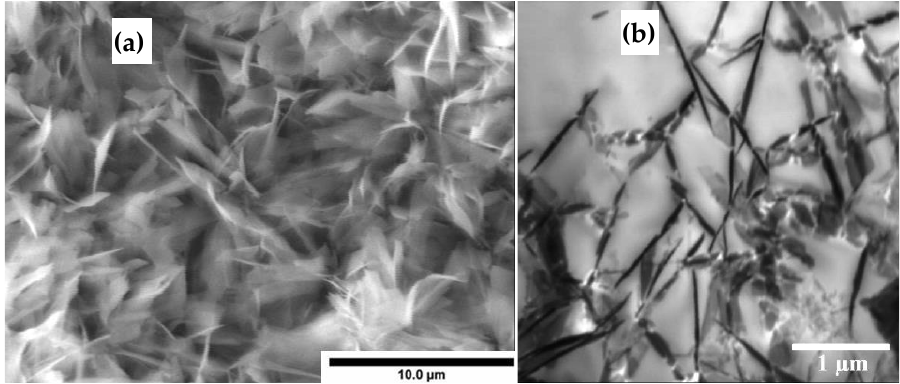
Figure 12. Calcium phosphate coating obtained by direct current electrodeposition. ( a ) SEM image and ( b ) TEM image. Reprinted with permission from Ref. [85]. Copyright 2012 Nova Science Publishers.